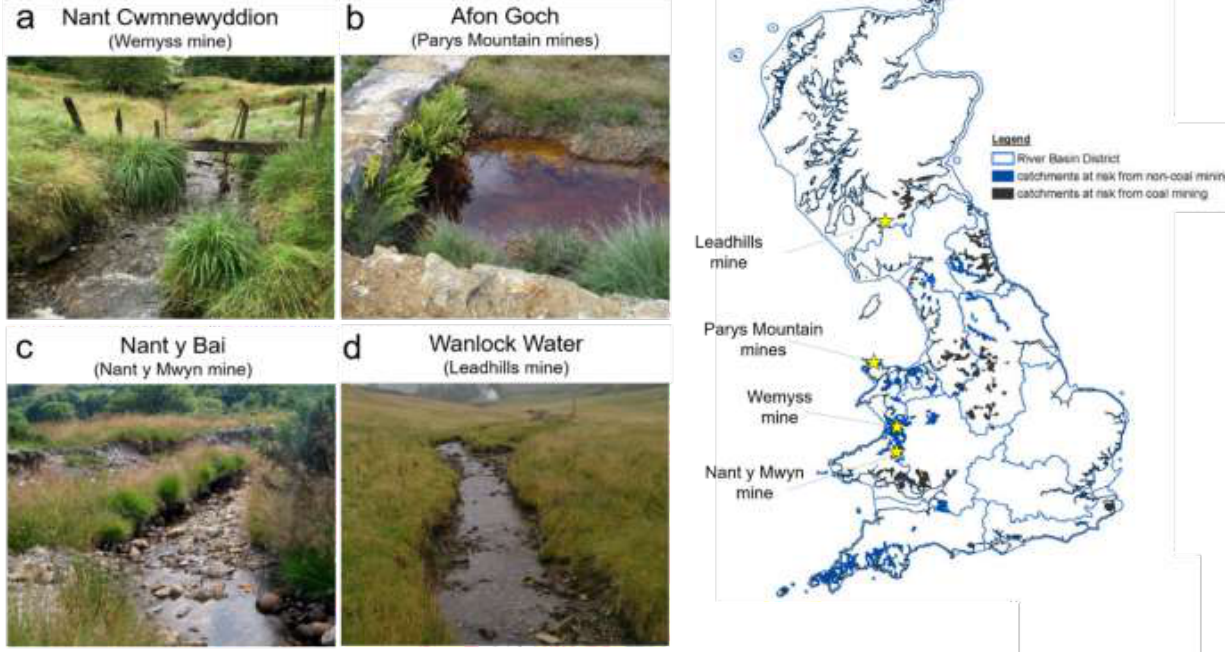
Figure 4. Example of polluted streams in the UK from where samples were collected and tested in the laboratory and in situ using microwave spectroscopy: Nant Cwmnewyddion ( a ), Afon Goch ( b ), Nant y Bai ( c ) (Wales) and Wanlock Water ( d ) (Scotland); the map is adapted from the Environment Agency [11] which shows catchments at risk from non-coal (in blue) and coal (in black) mines and highlights the four mining areas with yellow stars.